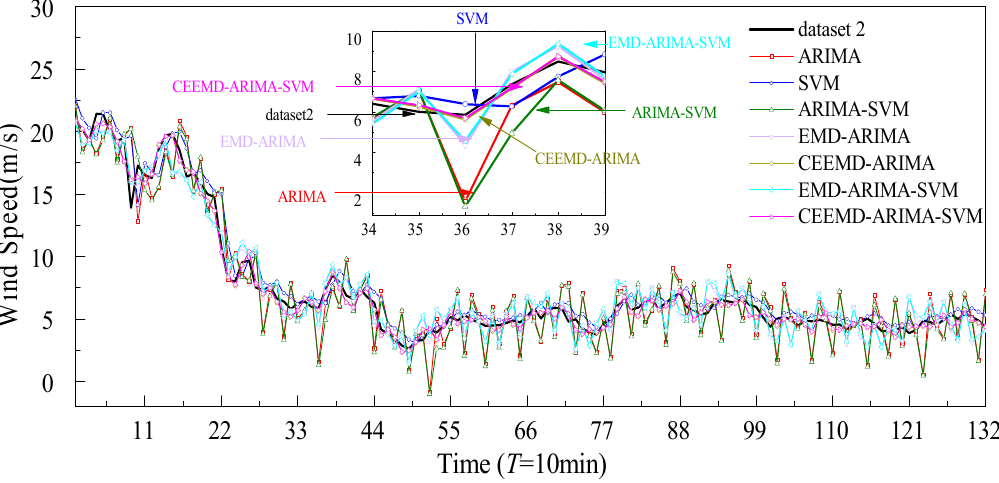
Figure 6. Comparative prediction results for dataset 1.